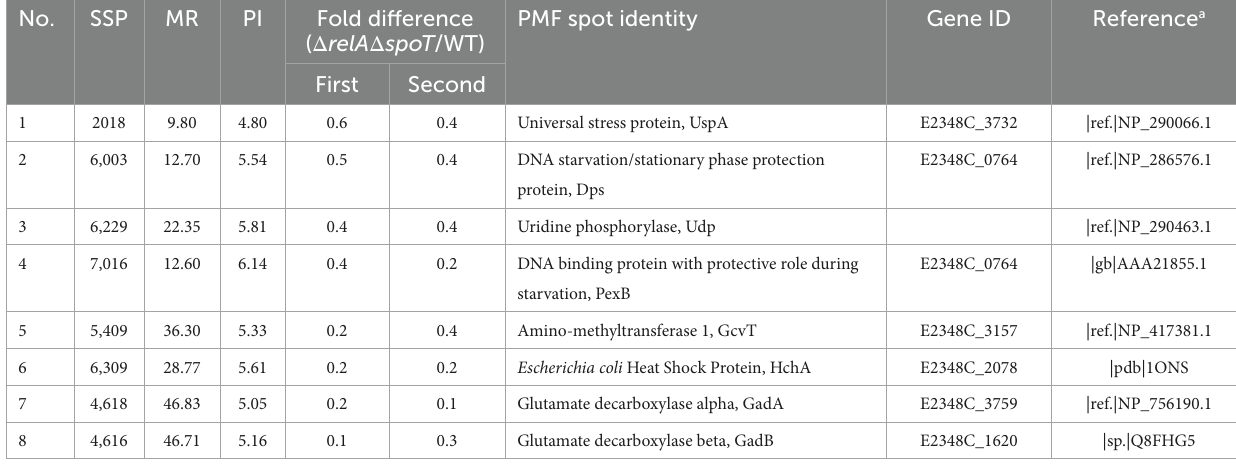
TABLE 2 Identification of EPEC proteins downregulated in the Δ relA Δ spoT EPEC (>1.5-fold). No.